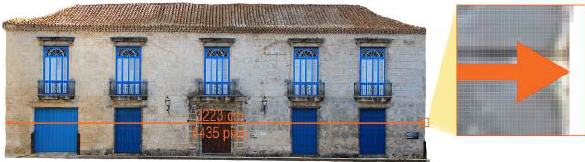
Figure 4. Metric survey